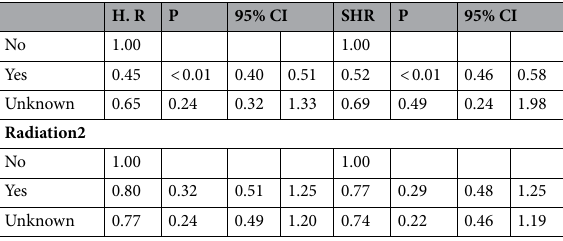
Table 5. Covariates associated with all-cause and cancer-specific death in patients with BCLA. All variables were used in multivariate analysis. Insurance1 first insurance status; Marital1 first marital status; Seerstage1 first cancer stage; Surgery1 first surgery; Radiation1 first radiation; Insurance2 secondary insurance status; Marital2 secondary marital status; Seerstage2 secondary cancer stage; Surgery2 secondary surgery; Radiation2 secondary radiation; H.R risk of all-cause death; SHR risk of cancer-specific death.